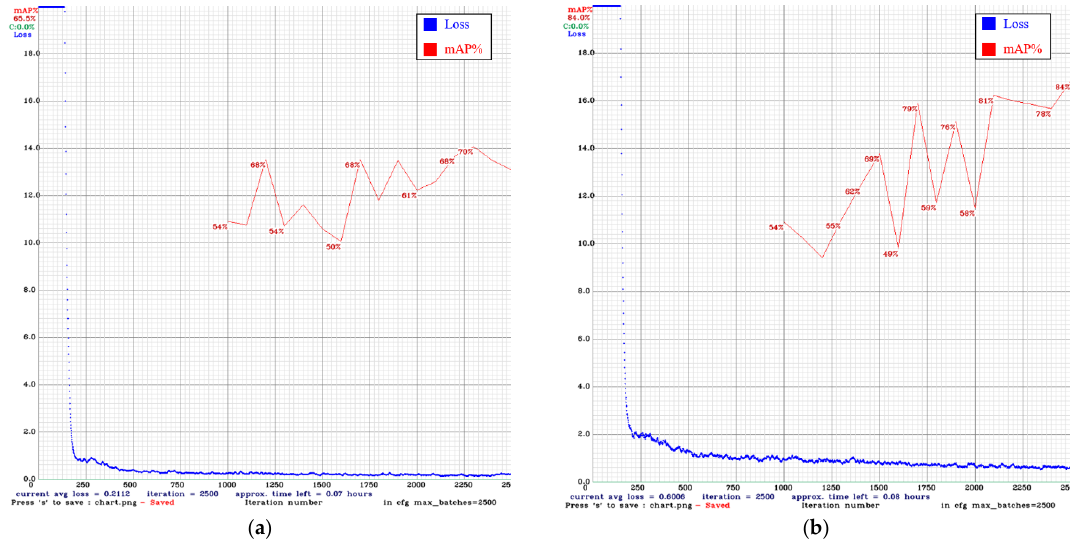
Figure 24. Training results for YOLO v3: ( a ) original images only ( b ) original images plus DCGAN synthetic images.